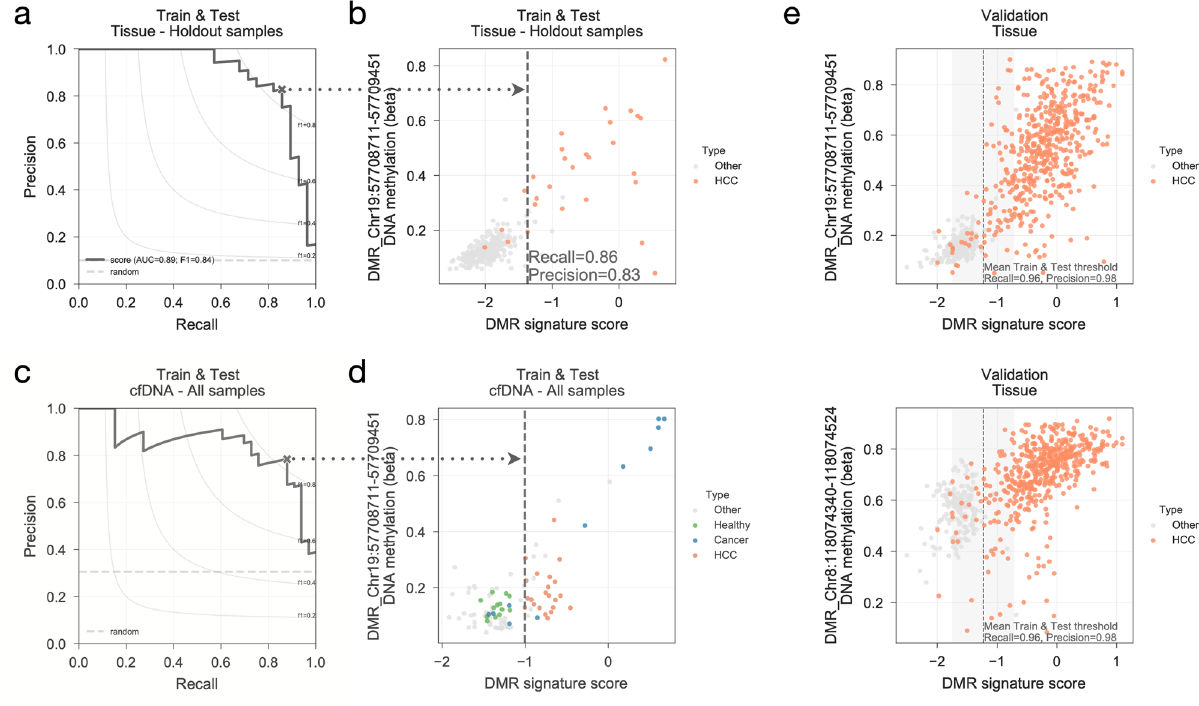
Figure 4. HCC DMR signature score. ( a ) precision-recall curve using the DMR signature score ranking the samples in the Train & Test dataset that were not used to define the DMR signature, i.e. were left out when training the models to identify the 38 DMRs and their associated weights. Maximum F1-score along the curve is represented with “x” and used to define the DMR signature score threshold at the given recall and precision. Random precision is drawn as a dashed horizontal line. ( b ) DMR signature score of Train & Test samples not used for HCC biomarker discovery plotted against a representative top performing DMR. Vertical line represents the DMR signature score threshold found at the maximum F1-score in ( a ) and the associated recall and precision rates are reported. ( c ) precision-recall curve of all cfDNA samples of the Train & Test dataset including samples from patients with other types of cancer (labeled as “Cancer” and coloured blue). ( d ) similar to ( b ), DMR signature score threshold, vertical dashed line, is estimated from the maximum F1-score point along the precision-recall curve in ( c ). ( e ) DMR signature score calculated for the Validation set samples plotted against two highly predictive HCC DMRs and their methylation profiles. Precision and recall rates reported are those estimated in the Validation dataset using the DMR signature score threshold calculated with the Train & Test